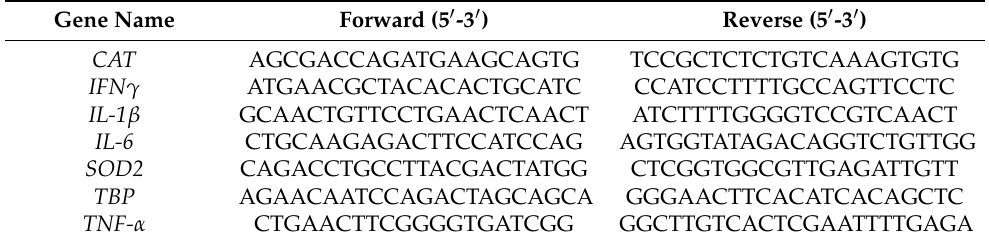
Table 3. Sequences of primers used for quantitative